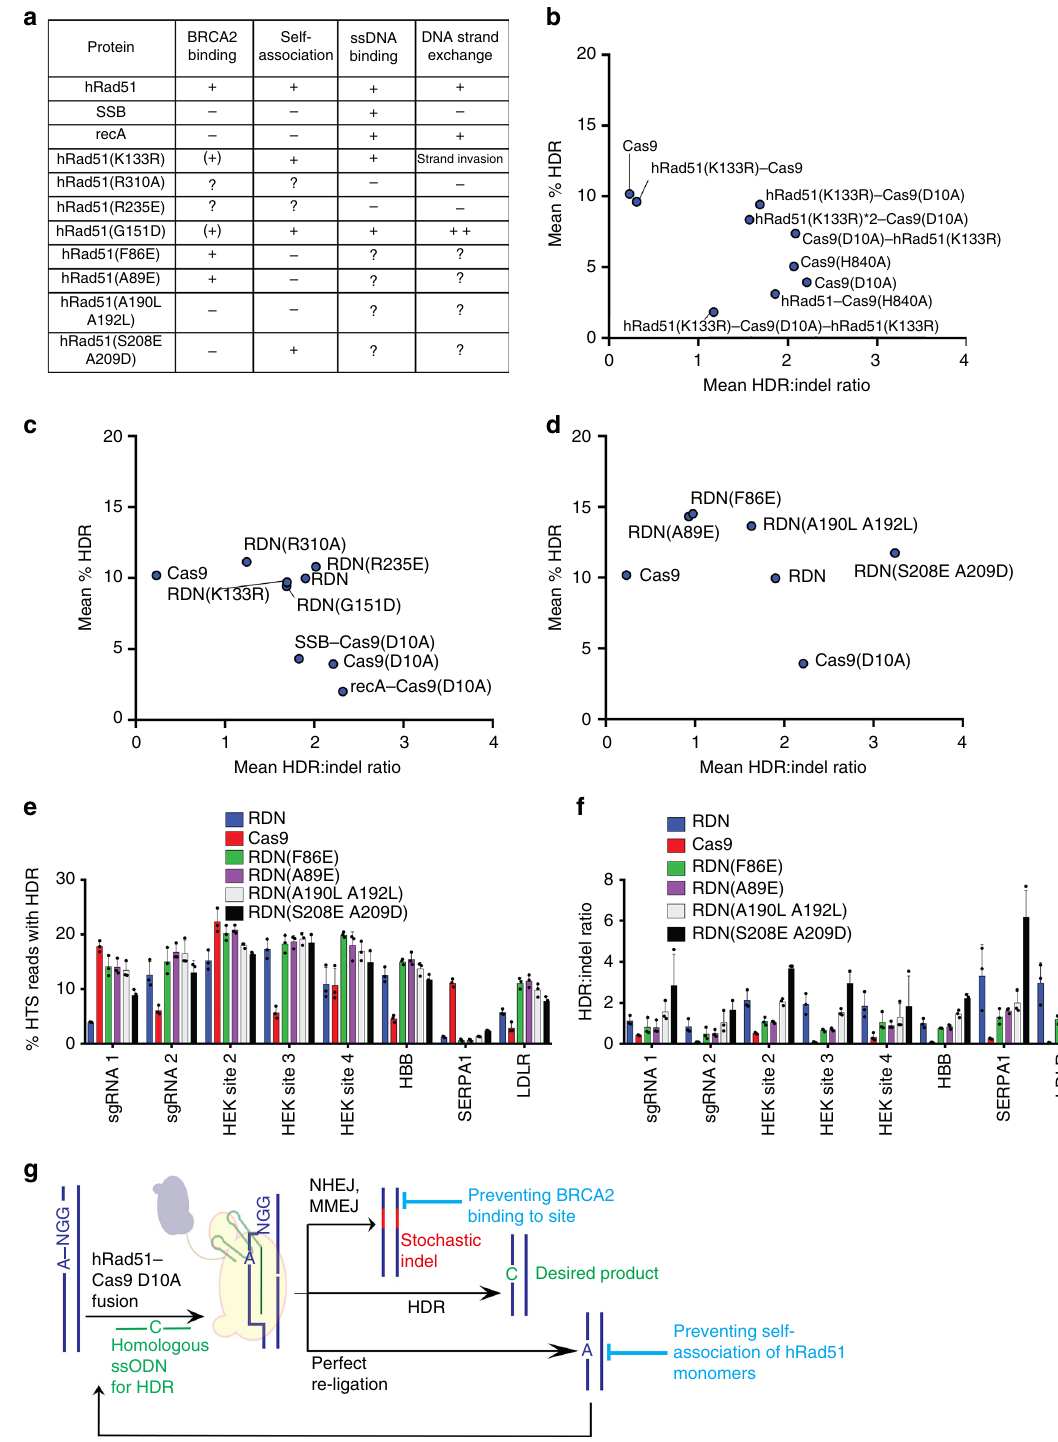
Fig. 3 HDR frequencies associated with fusion constructs between hRad51 and its mutants and Cas9 or Cas9 nickases. a Catalytic activity and protein- protein binding interactions associated with hRad51, mutants of hRad51 and the homologous protein recA. + indicates activity has been validated; – indicates the absence of activity has been validated; ? indicates activity is unknown; ( + ) indicates activity has not been explicitly validated but is expected from structural data; and ++ indicates improved activity relative to wild type. b – d Dot plots depicting the average HDR frequencies and the average HDR: indel ratio associated with the indicated construct measured by high-throughput sequencing in unsorted HEK293T cells at eight loci. b Comparison between fusion constructs between Cas9(D10A) and hRad51(K133R) with different fusion architectures. c Comparison between catalytic mutants of hRad51 bound to the N-terminus of Cas9(D10A). d Comparison between binding mutants of hRad51 bound to the N-terminus of Cas9(D10A). e HDR frequencies associated with hRad51 and the mutants depicted in d , plotted by genomic locus. f HDR:indel ratio associated with editing at eight loci. For e , f , data are shown as individual data points and mean ± s.d. for n = 3 independent biological replicates, performed on different days. g Model of possible editing outcomes from hRad51 – Cas9(D10A) nickase fusions. Source data are provided in the Source Data fi